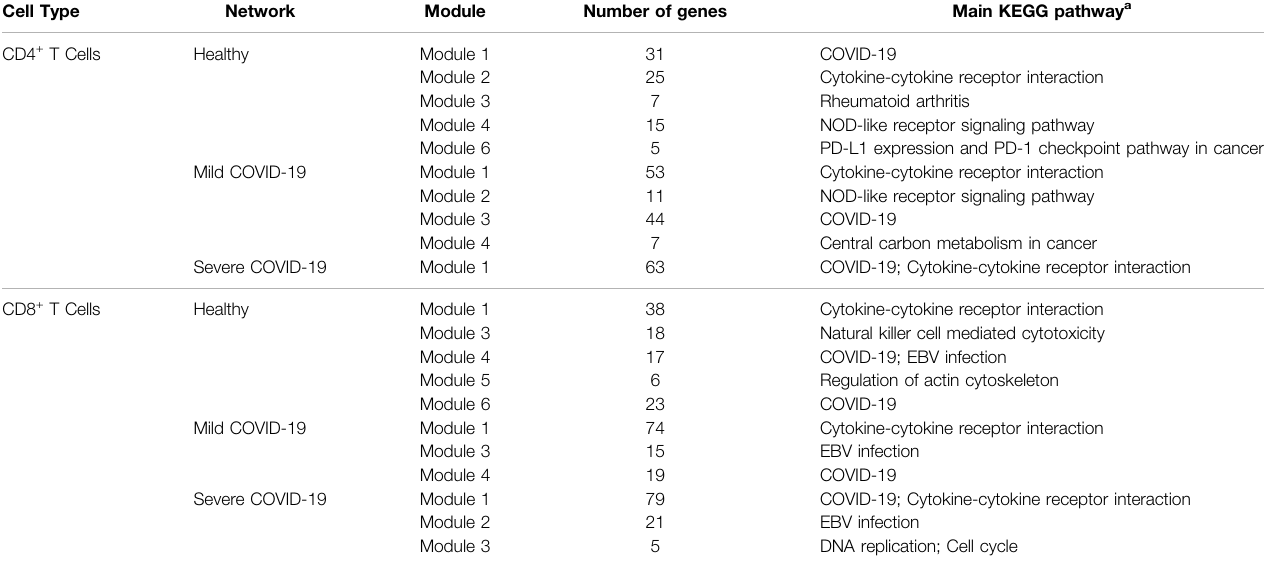
TABLE 4 | The main KEGG pathway of each module of each network. Cell